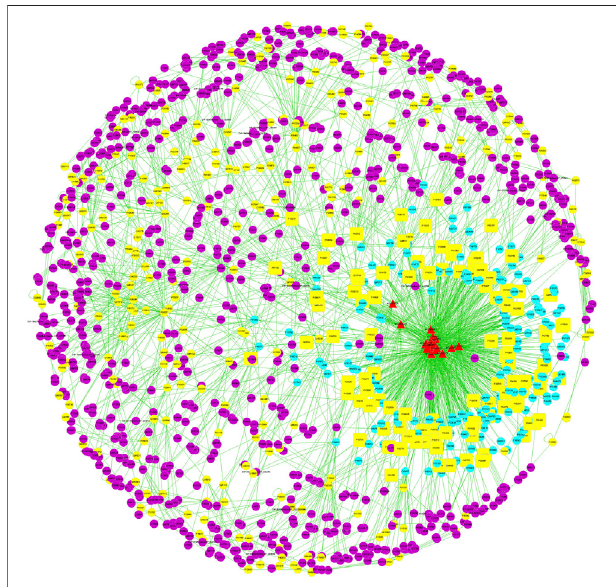
FIGURE 1 | Prediction of the effective targets of LWWL with network